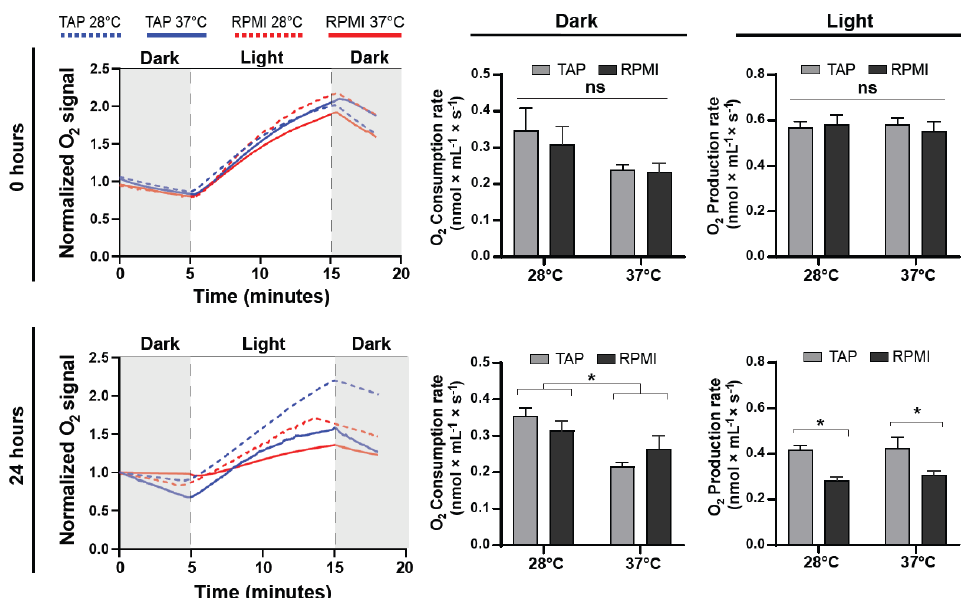
Figure 2. Effect of the mammalian culture conditions in the metabolic profile of C. reinhardtii . Mi- croalgae were cultured at 28 or 37 °C in TAP or RPMI for 24 h, and their oxygen production and consumption were evaluated. At time zero, no significant differences were observed among all groups (upper panels). After 24 h in culture, oxygen consumption rate decreased at 37 °C, while production decreased in RPMI at both temperatures. All assays were performed in at least three independent experiments and data are presented as average + SE. p ≤ 0.05 was considered as signif- icant using a two-way ANOVA, with different letters implying statistical differences. * = p ≤ 0.05, ns = not